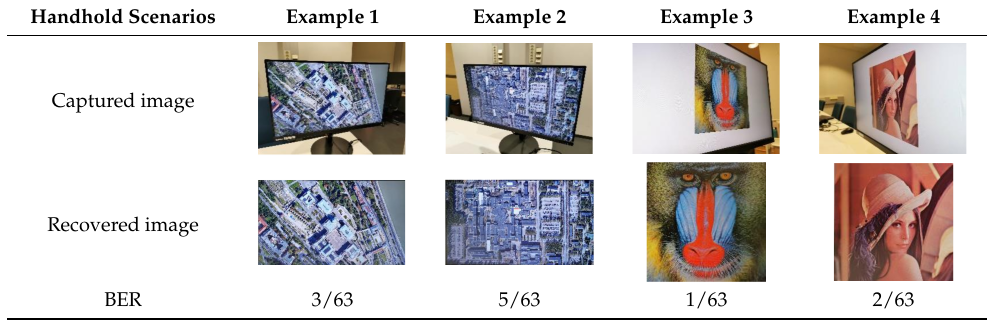
Table 11. Examples of handhold shooting.